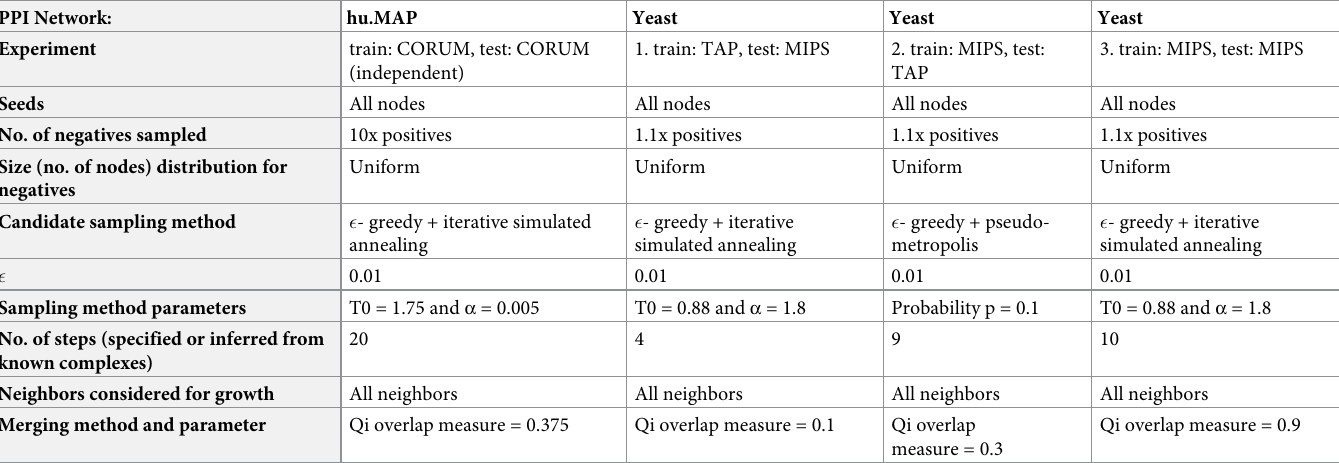
Table 1. Best parameters found and used in each of the experiments.